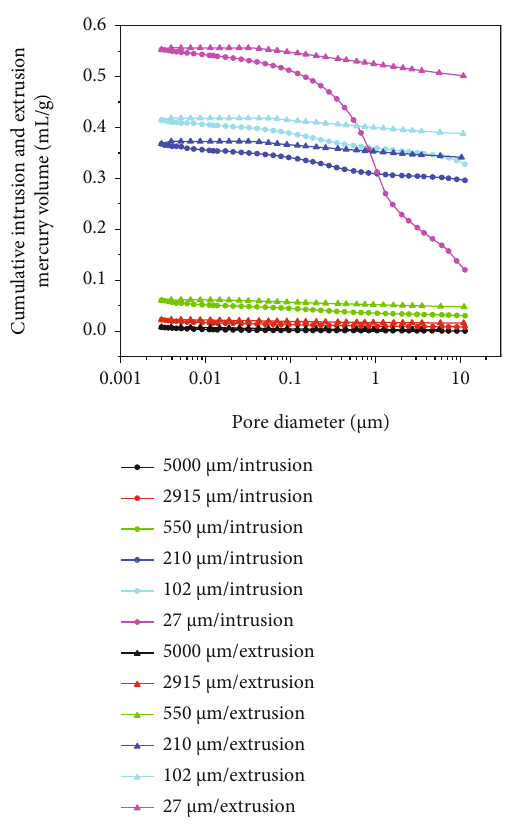
Figure 5: Mercury intrusion and extrusion curves of shale samples with di ff erent particle sizes.